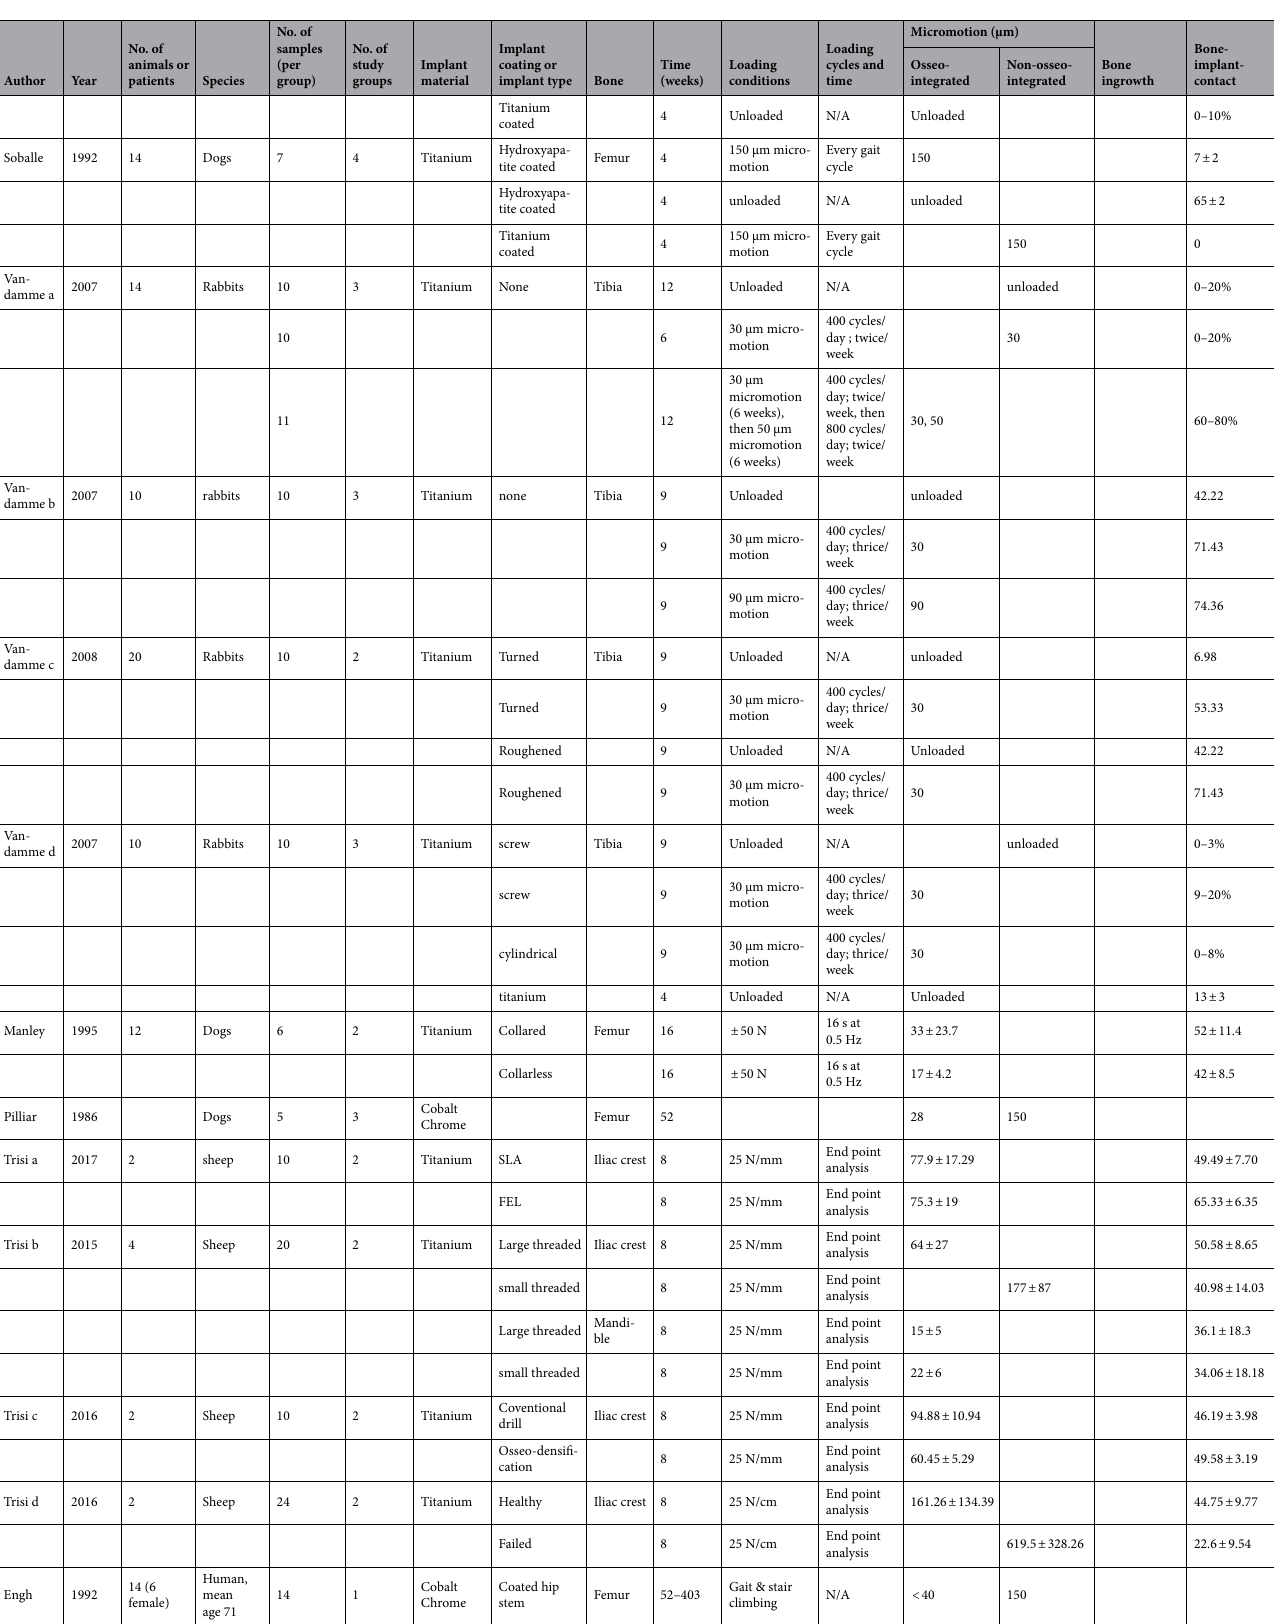
Table 2. Detailed study characteristics of the selected